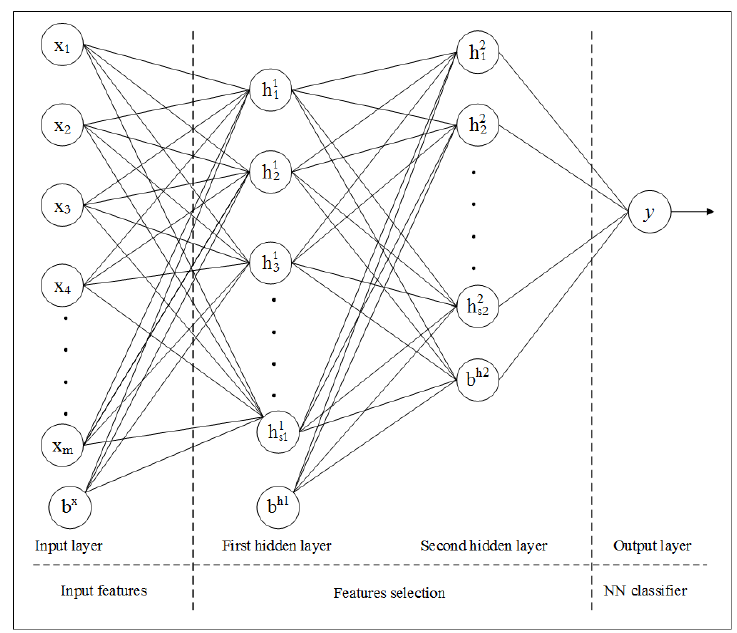
Figure 5. Structure of presented S-SAE